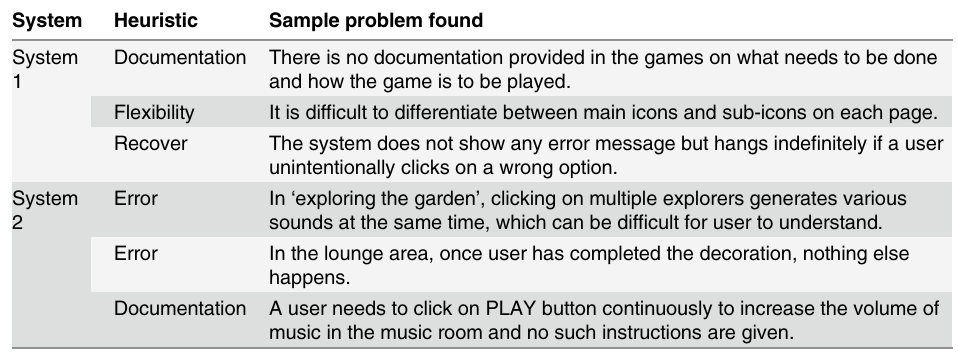
Table 9. Examples of problems found using 5 improved